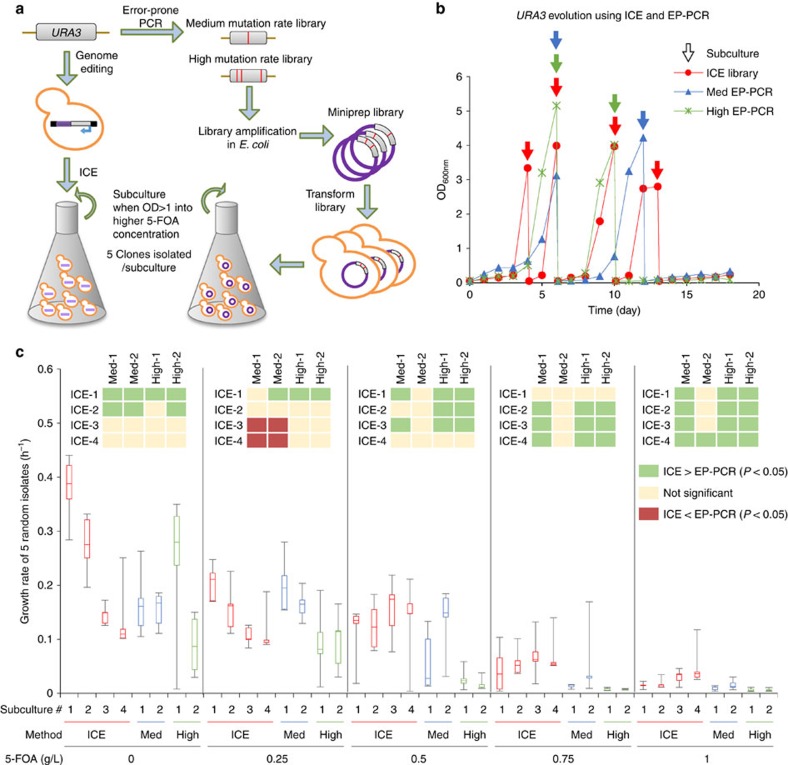
Comparison of ICE to error-prone PCR.The ability of ICE to generate 5-FOA-resistant mutants of URA3 was evaluated in parallel with error-prone PCR. (a) Workflow for parallel evolution experiment is diagrammed. (b) Culture cell densities were monitored as selections progressed. Each time the OD600 of the culture exceeded 3, a portion was transferred to a new flask containing a 0.25 g l−1 increased concentration of 5-FOA (denoted by the presence of a coloured arrow). (c) Five random clones were isolated from each subculture (denoted by the number after the dash, for example, ICE-3 refers to clones isolated from the ICE library in subculture 3) and their growth was compared in varying concentrations of 5-FOA. Lines on boxplots in c represent, from top to bottom, maximum observed value, 75th percentile, median, 25th percentile and minimum observed value. P-values used to generate heatmaps were computed using a Mann–Whitney U-test.